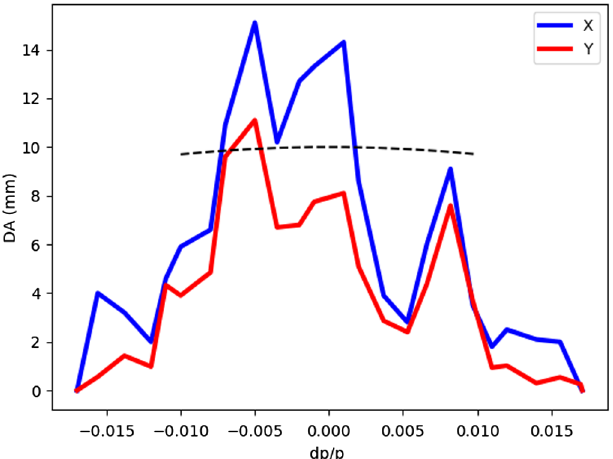
FIG. 13. Dynamic aperture vs momentum offset, β x ¼ 50 m,